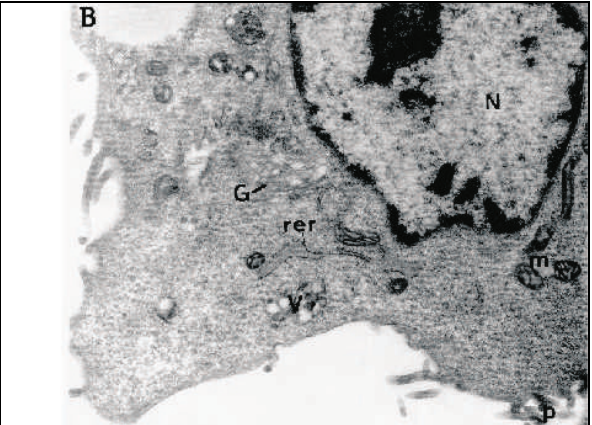
FIGURA 3a – Elétron-micrografia de células tumorais de Ehrlich do grupo-controle. Aspecto geral da célula tumoral: Núcleo (N) com nucléolo (nu) exuberante, citoplasma rico em ribossomas livres e com poucas mitocôndrias (m), notar as projeções filiformes da superfície celular.X 10.000.